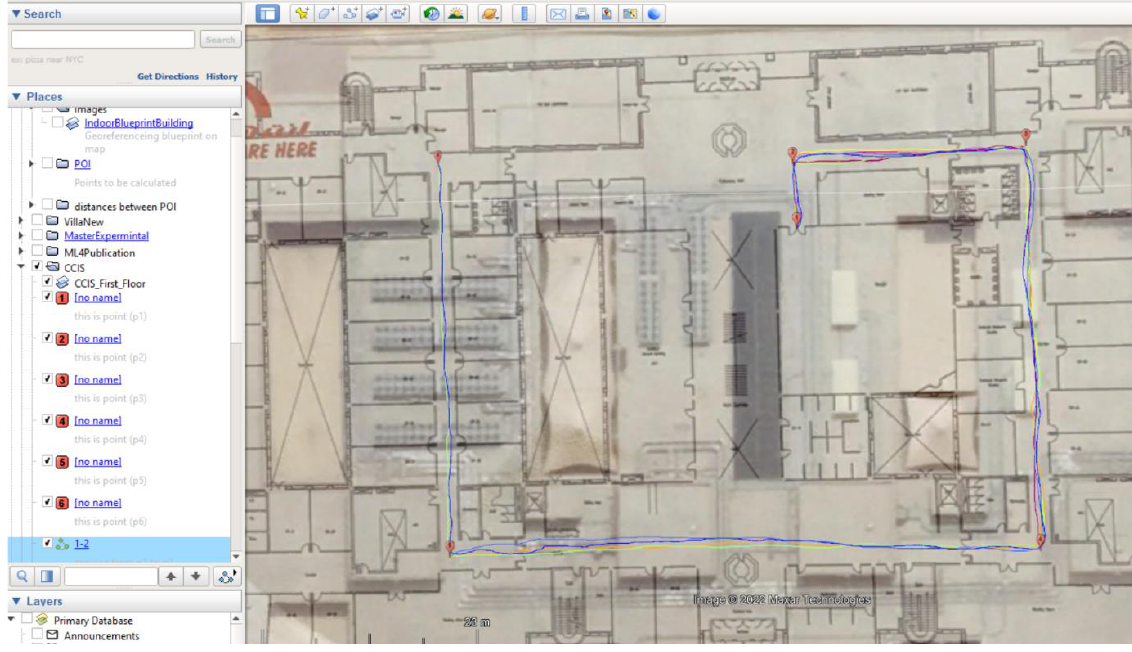
Figure 38. Georeferencing and drawing paths.